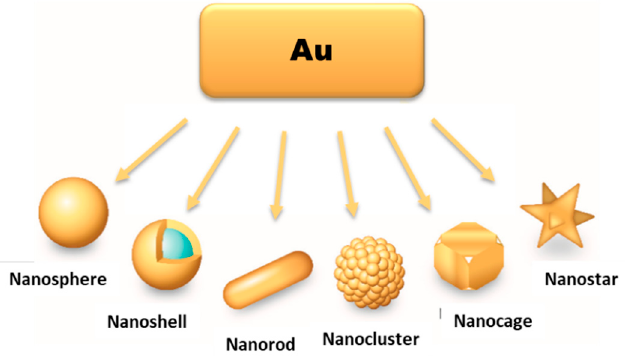
Figure 2. Different types of AuNPs, according to their shape and morphology. Adapted from L. F. de Freitas et al. (2018) [21].